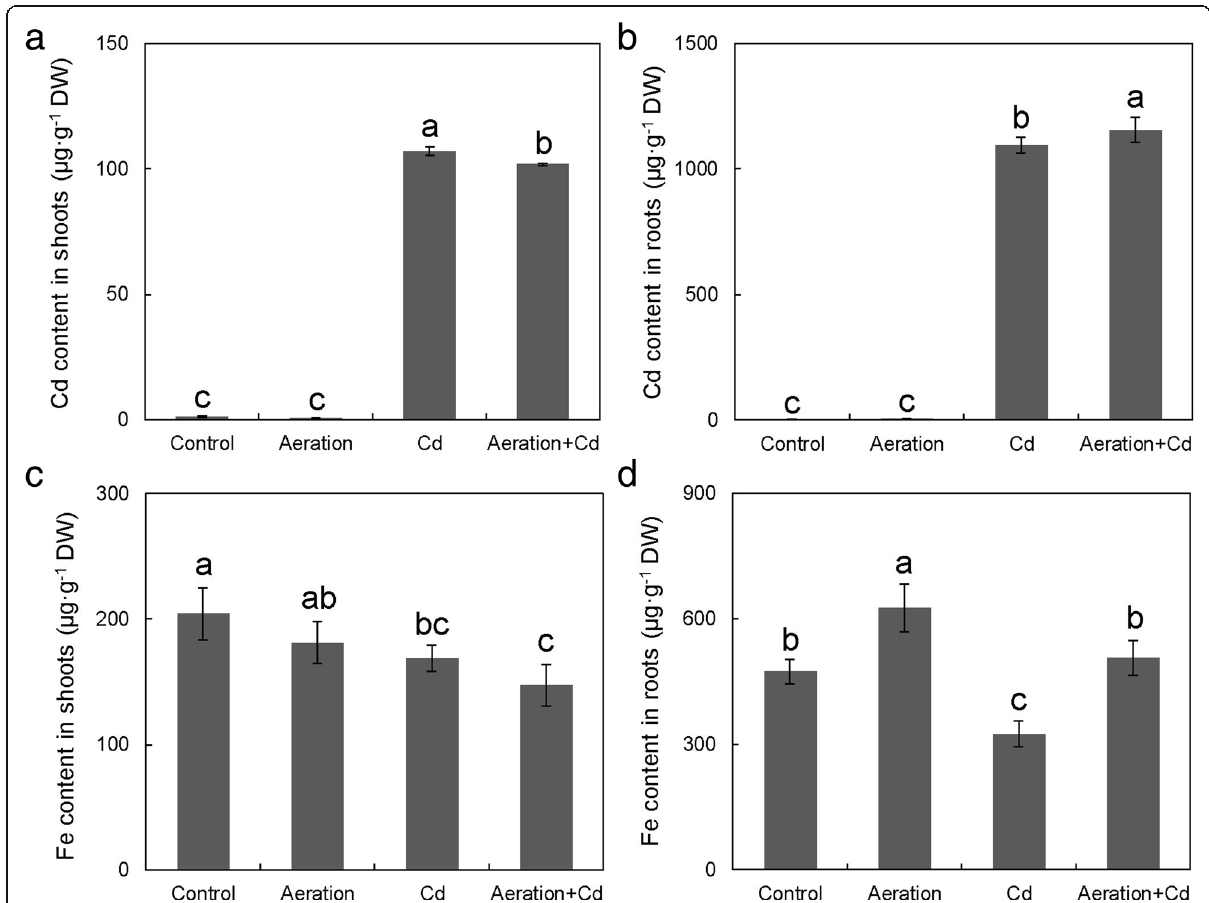
Fig. 5 Effects of aeration or/and 50 μ M CdCl 2 treatments on Cd and Fe content in shoots and roots of rice seedling. a Cd content in shoots; b Cd content in roots; c Fe content in shoots; d Fe content in roots. The 3-week-old rice seedlings under hydroponic culture were aerated with air pump (30 min per hour) in the absence or presence of 50 μ M CdCl 2 for 14 d. The values are means ± SE ( n = 3). Different letters on bar indicate significant differences at P <